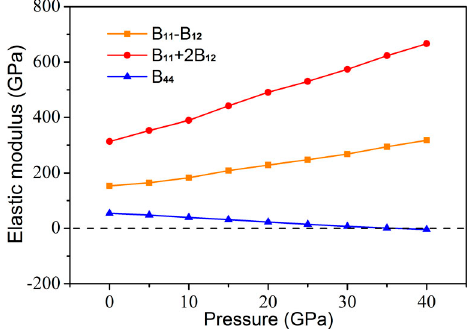
Figure 4. Elastic modulus of GaFe(CN) 6 under different pressures.